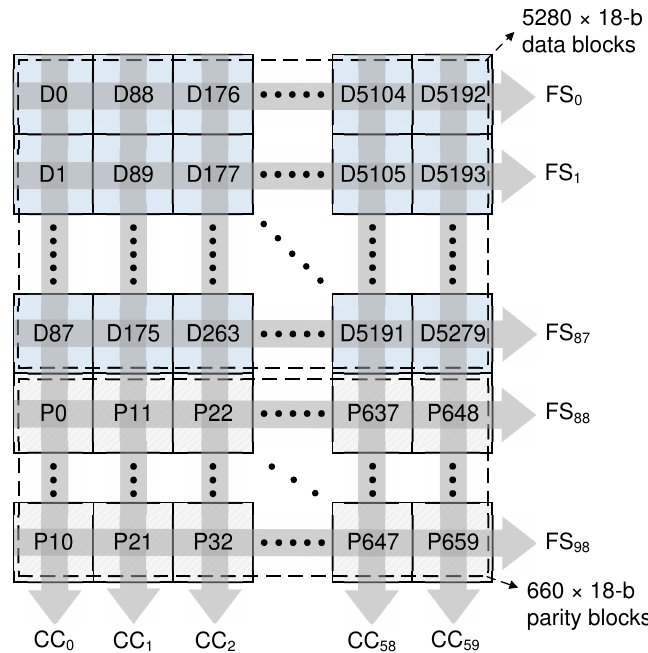
Figure 3. Construction of the proposed interleaved BCH codes.